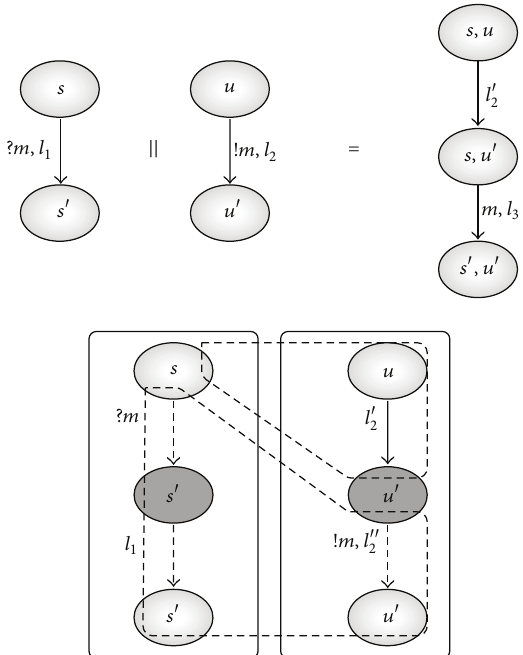
Figure 10: A transition composition of